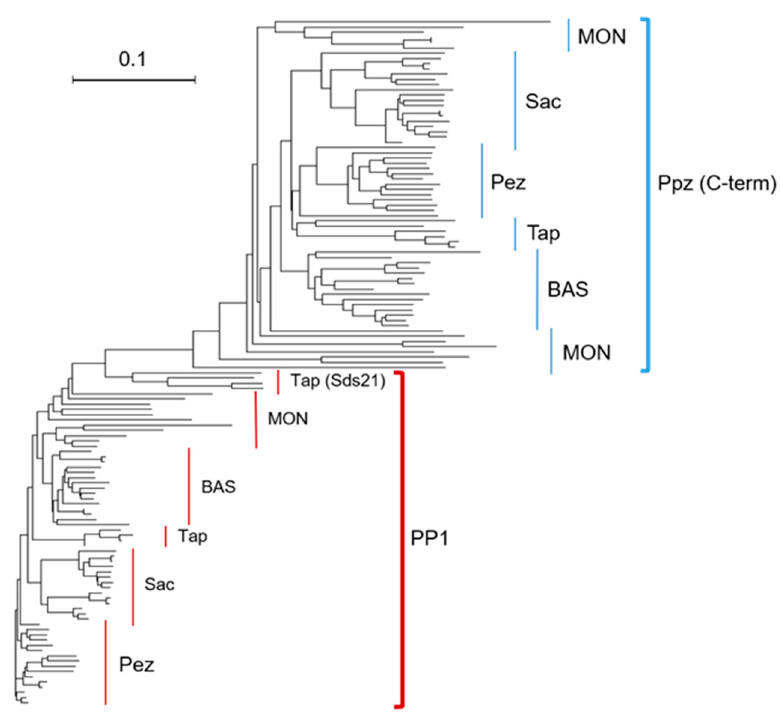
Figure 2. PP1 enzymes are more conserved than PPZ across fungi. Phylogenetic tree containing the sequences of PP1 and the catalytic regions of PPZ proteins. Phylogenetic tree data generated from Clustal Omega alignments was visualized using the Dendroscope software (version 3.7.3) as rectangular phylogram [36]. Pez: Pezizomycotina. Sac: Saccharomycotina. Tap: Taphrinomycotina. BAS: Basidiomycota. MON: “Monokaryotic” fungi.